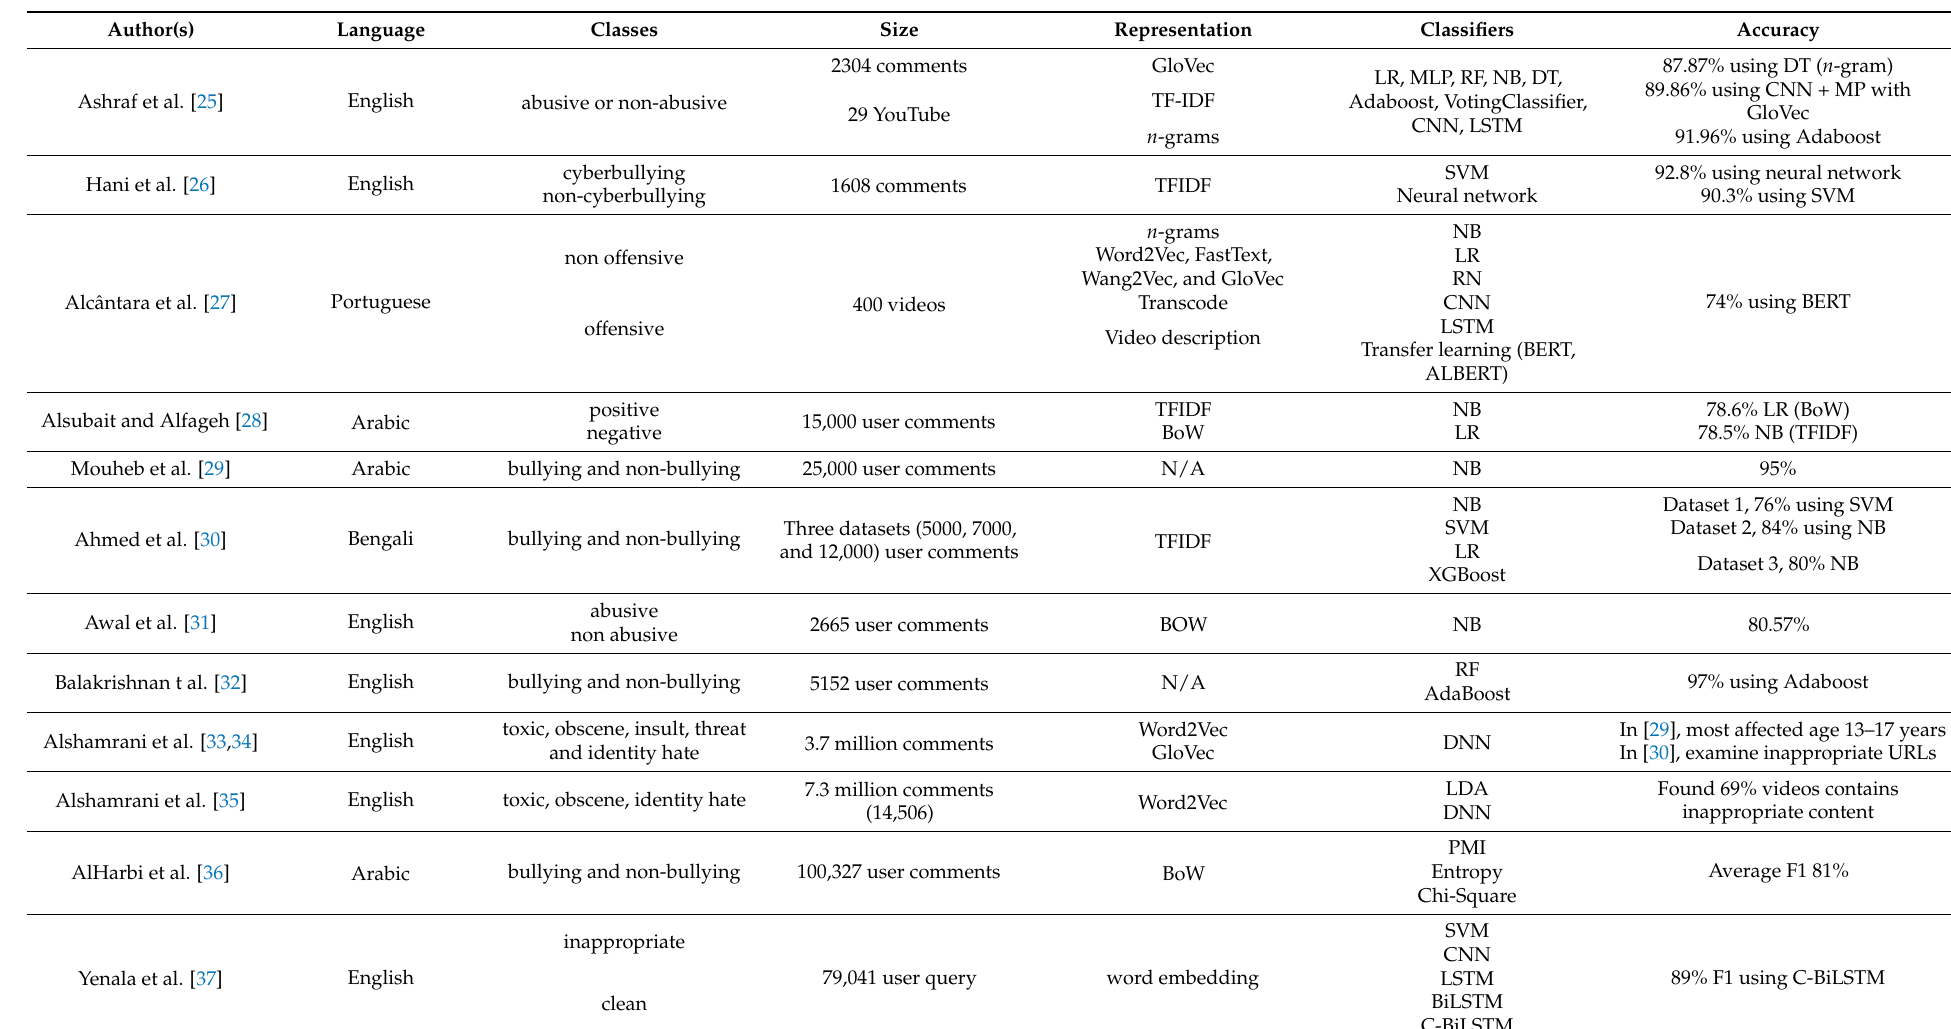
Table 2. Comparative study among existing